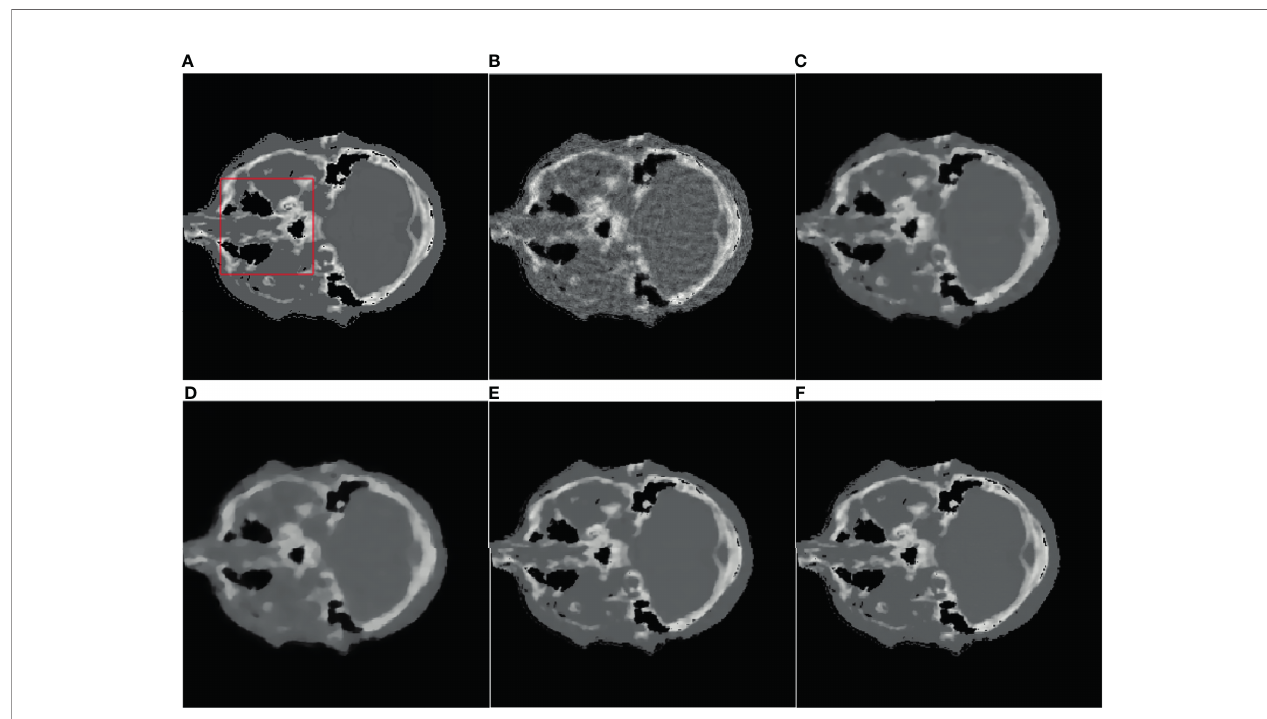
FIGURE 1 | Reference image and 32-angle reconstruction results: (A) reference image; (B) SART; (C) ASD-POCS; (D) SART-TV; (E) TpV; (F) TpV-GIF.